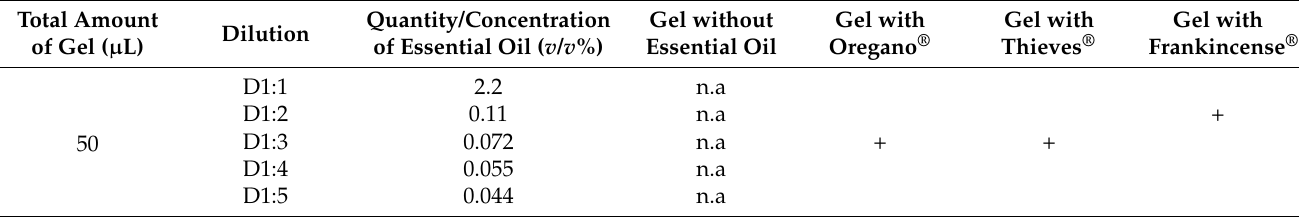
Table 2. Bacteriostatic effect: MIC (minimum inhibitory concentration).